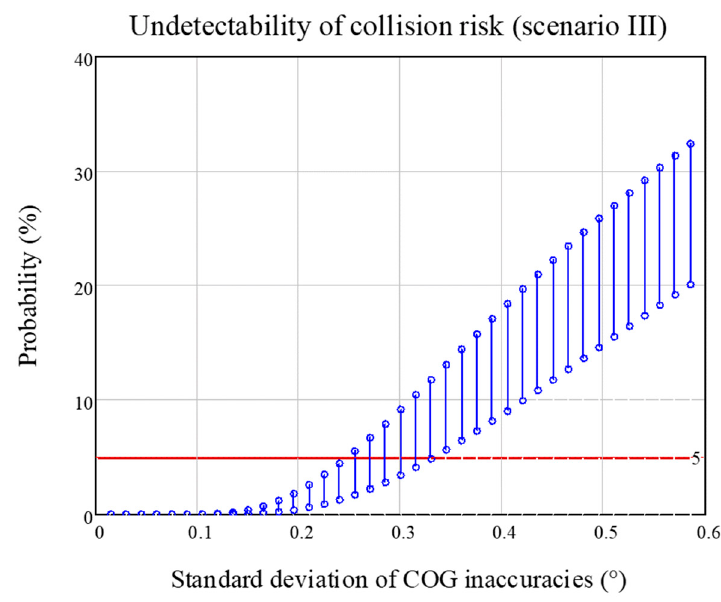
Figure 12. Range of probabilities of undetected collisions risks dependent on the standard deviation of COG inaccuracies (L = 100 m, provided for a forecast time δ t = 6 min and equally distributed SOG values between 0 and 25 kn).